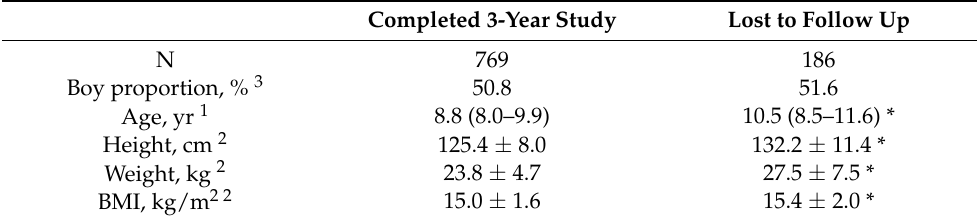
Table 2. Comparison of characteristics of subjects with completed two years and lost to follow-up at baseline (means ± SDs).